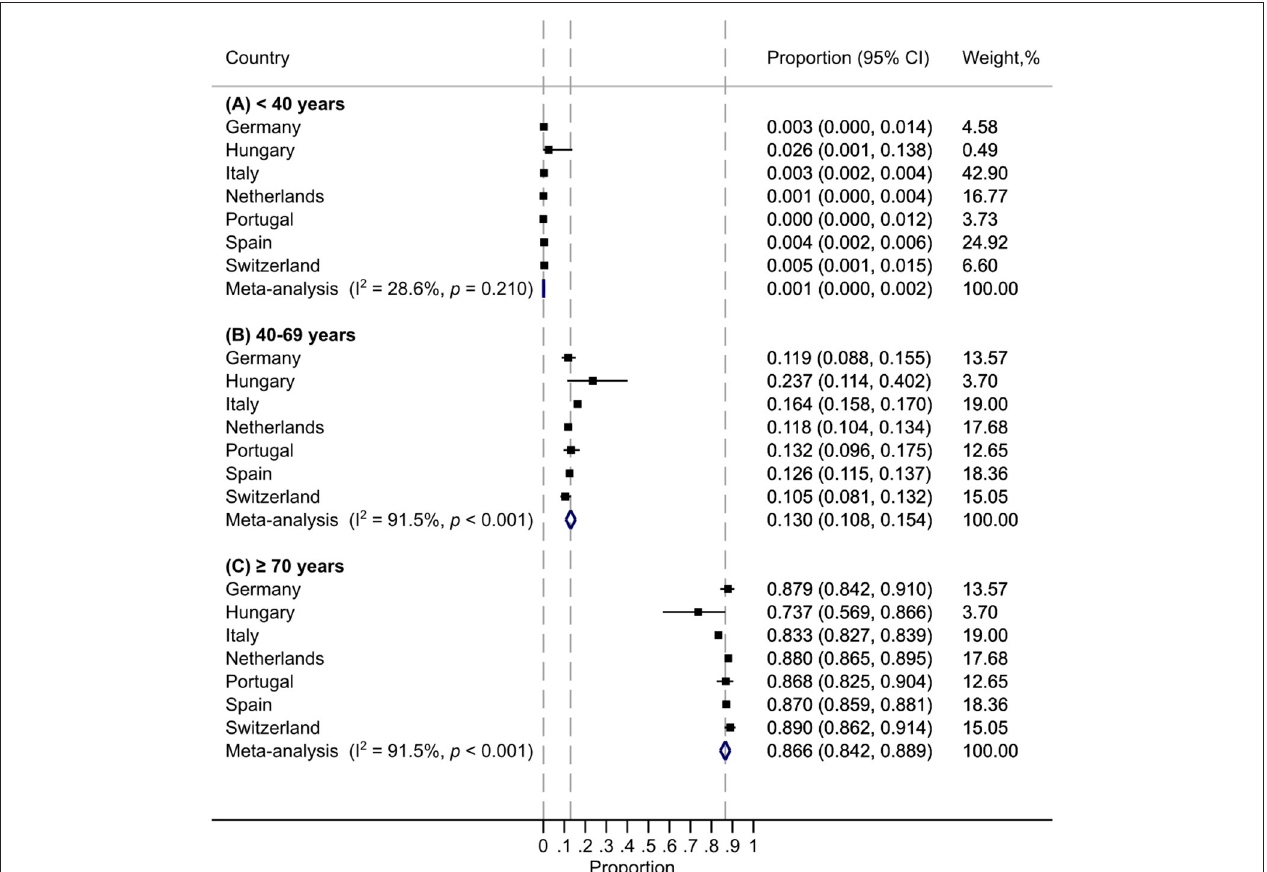
FIGURE 1 | Distribution of age groups for all COVID-19–related deaths in Europe: meta-analysis. Each vertical dashed line is aligned with the meta-analysis summary estimate of the corresponding age group.